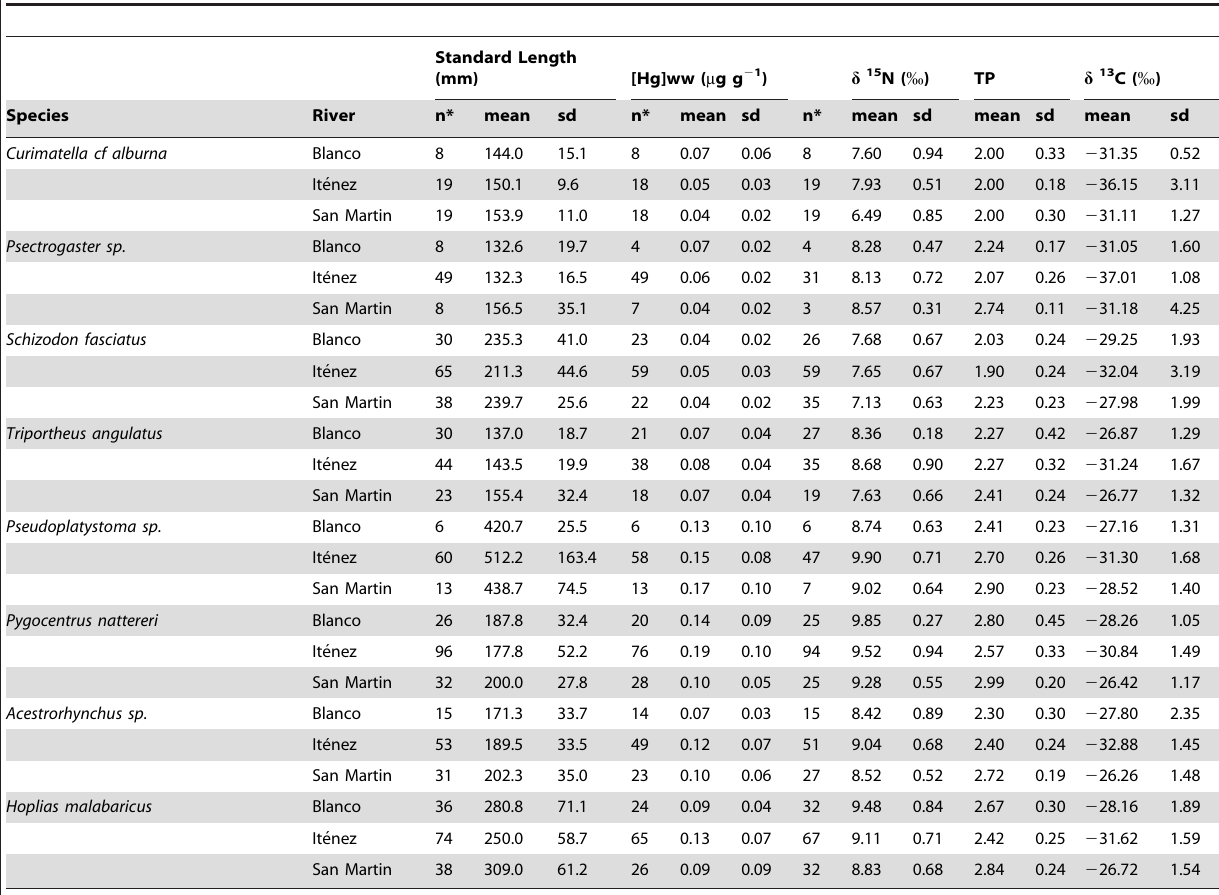
Table 2. Standard Length, mercury concentration and isotope signature ( d 15N and relative Trophic Position - TP, d 13C) of eight fish species populations sampled in three rivers of the Ite´nez basin (Amazon, Bolivia).